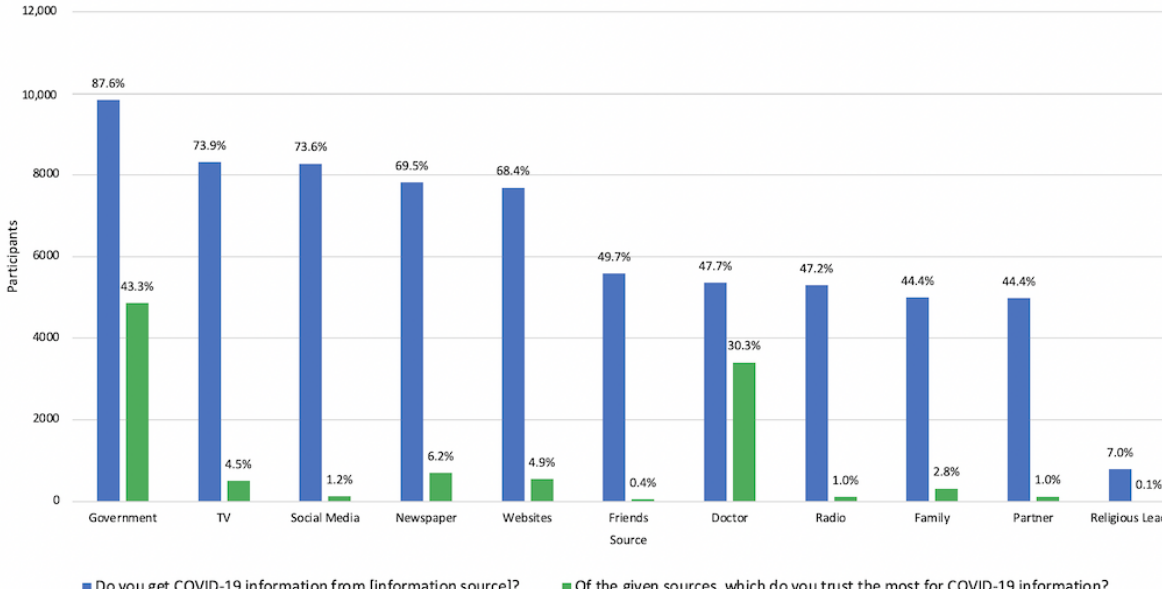
Figure 1. Distribution of sources used and most trusted sources for information on COVID-19